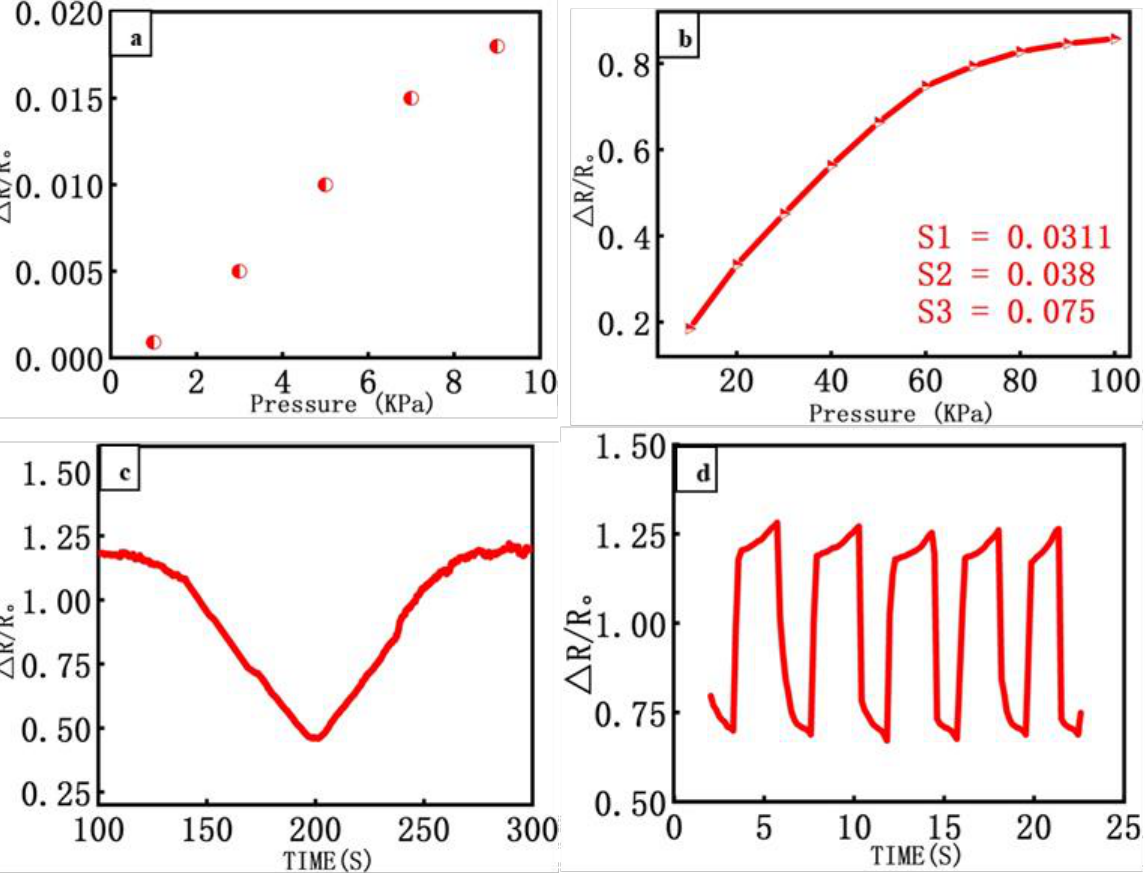
Figure 2. Resistance variations in response to the tiny stimulus pressures ( a ) and large loading range from 10 to 100 kPa. ( b – d ) Resistance response of the piezoresistive tactile sensor to an applied normal force of 15.75 N and shear force. We measured the performance using the sensitivity ( S ) metric as defined in Equation.